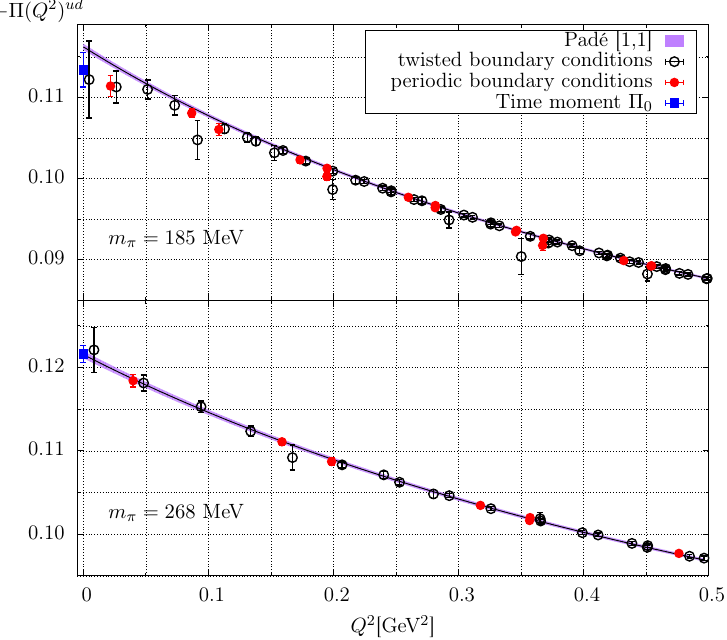
Figure 1 . The u; d contributions to the vacuum polarization function in the range 0 < Q 2 0 : 5 GeV 2 for ensembles G8 (top) and O7 (bottom). Data points corresponding to Fourier momenta are represented by (cid:12)lled red circles, while open black circles denote data points computed using twisted boundary conditions. The curves represent the (cid:12)ts using a Pad(cid:19)e approximant of order [1 ; 1]. Blue (cid:12)lled squares indicate the value of (cid:5)(0) determined from the second time